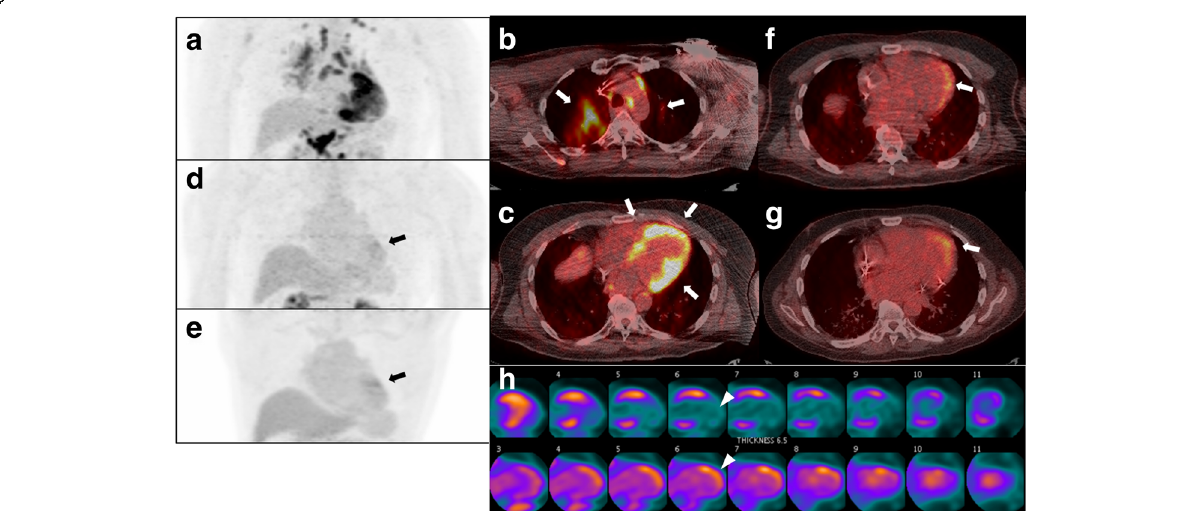
Fig. 3 Representative case from the group with daily maintenance dose of prednisone of > 10 mg (patient no. 12). Pretreatment FDG PET/CT ( a 3D maximum intensity projection; b , c fused PET/CT) demonstrate multiple organ disease involving lymph nodes (thoracic and abdominal), the lung ( b arrows), and heart ( c arrows). The max SUV, metabolic volume, and total lesion glycolysis of all involved organ system and the heart are 15.9 (heart), 580.3 ml, and 2782.5 g, and 15.9, 246 ml, and 1393.9 g, respectively. Follow-up PET/CT performed at 3 months since the initial study ( d , f ) show near complete metabolic resolution except for persistent metabolic activity in the heart ( d , f arrows, max SUV 4.0). The patient was started with 30 mg of daily corticosteroid, but the dose was increased to 40 mg at 3 months visit, which was later reduced to 15 mg at 6 months. The patient continued on corticosteroid therapy for years and later methotrexate was added to the treatment regimen, though follow-up PET/CT at 4 years since the initial study still show persistent metabolic activity ( e , g arrows, max SUV 4.1) in the heart. Reconstructed vertical long axis images of the left ventricle at 4 years since the initial study ( h perfusion images on the top and FDG images on the bottom) show increased metabolic activity in the anterior and anterolateral wall with corresponding reduced perfusion (arrowheads), suggestive of active inflammation. Note that reduced perfusion in the apical 1/2 of the inferior wall without FDG activity is compatible with scar